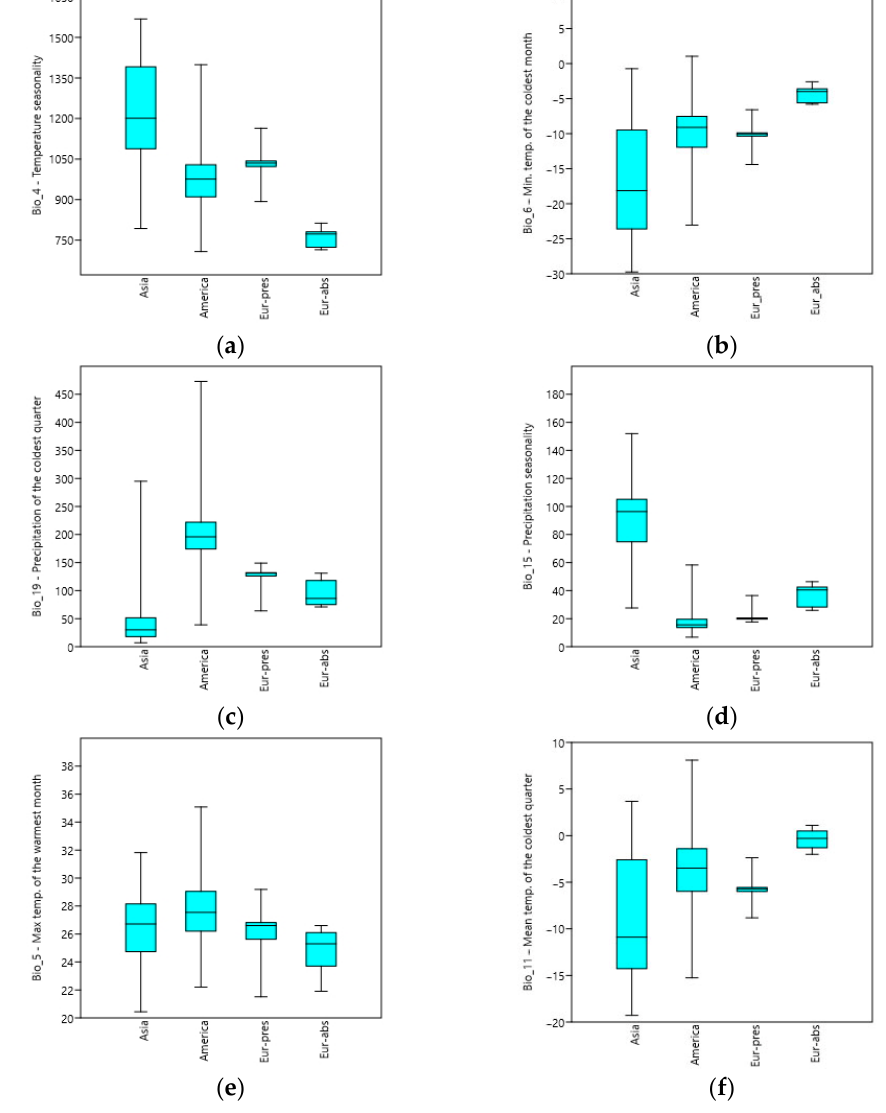
Figure 3. Boxplots representing the ranges of the bioclimatic variables in di ff erent regions (Asia, North America, Eur-pres—points with EAB detected in European part of Russia and Ukraine; Eur- abs—points with EAB not predicted in analyzed part of Europe; whisker type—Stand. dev., whisker length—one sigma, quartile method—interpolation); ( a ) Bio_4; ( b ) Bio_6; ( c ) Bio_19; ( d ) Bio_15; ( e )